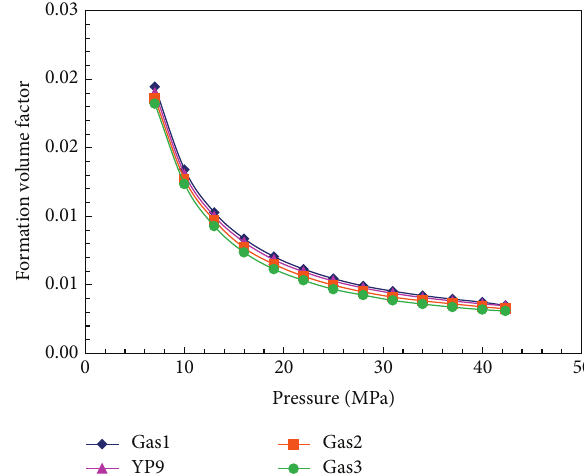
Figure 10: Variation of the volume factor of different CO 2 content natural gas samples with pressure at 127.5 ∘ C.